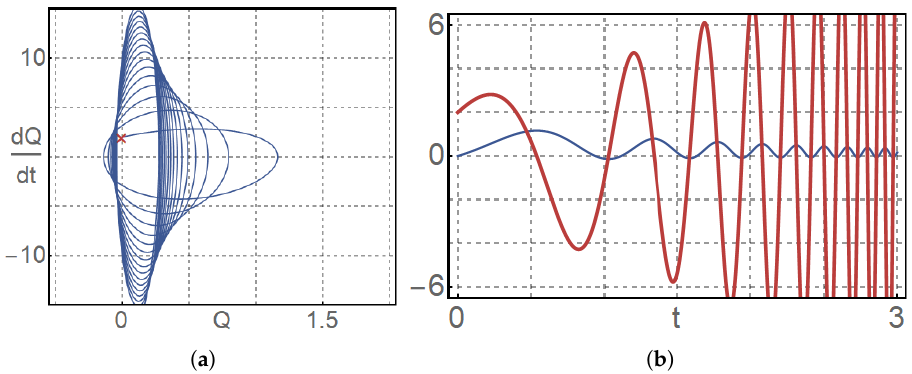
Figure 2. ( a ) Trajectories in the configuration space ( Q , ˙ Q ) for Γ = 1 in the interval t ∈ ( 0,3 ) , with w 0 = 1, Ω 0 = 1.5, and v 0 = 2. The initial conditions are Q ( 0 ) = 0, and ˙ Q ( 0 ) = 2. The red cross depicts the initial condition. ( b ) The time-dependent functions Q ( t ) (blue-solid) and ˙ Q ( t ) (red-thick-solid) for the above-mentioned